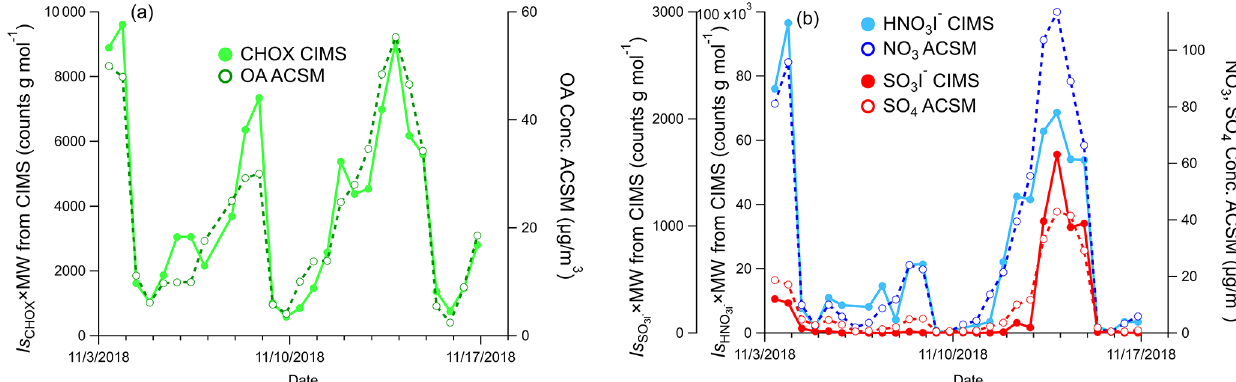
Figure 7. Comparison of the time series of the integrated signals of inorganic and organic compounds from 12h samples (2mm punches) analyzed by offline FIGAERO-CIMS and chemical components measured in situ by ToF-ACSM. (a) Total CHOX from FIGAERO-CIMS and OA from ToF-ACSM. (b) HNO 3 I − from FIGAERO-CIMS and NO 3 from ToF-ACSM. (c) SO 3 I − from FIGAERO-CIMS and SO 4 from ToF-ACSM. To compare with the PM 2 . 5 component concentrations from the ToF-ACSM, the Is of each compound from FIGAERO-CIMS was multiplied by their molecular weight (MW) in panels (a) and (b) . Note that FIGAERO-CIMS and ToF-ACSM data are on different axes.